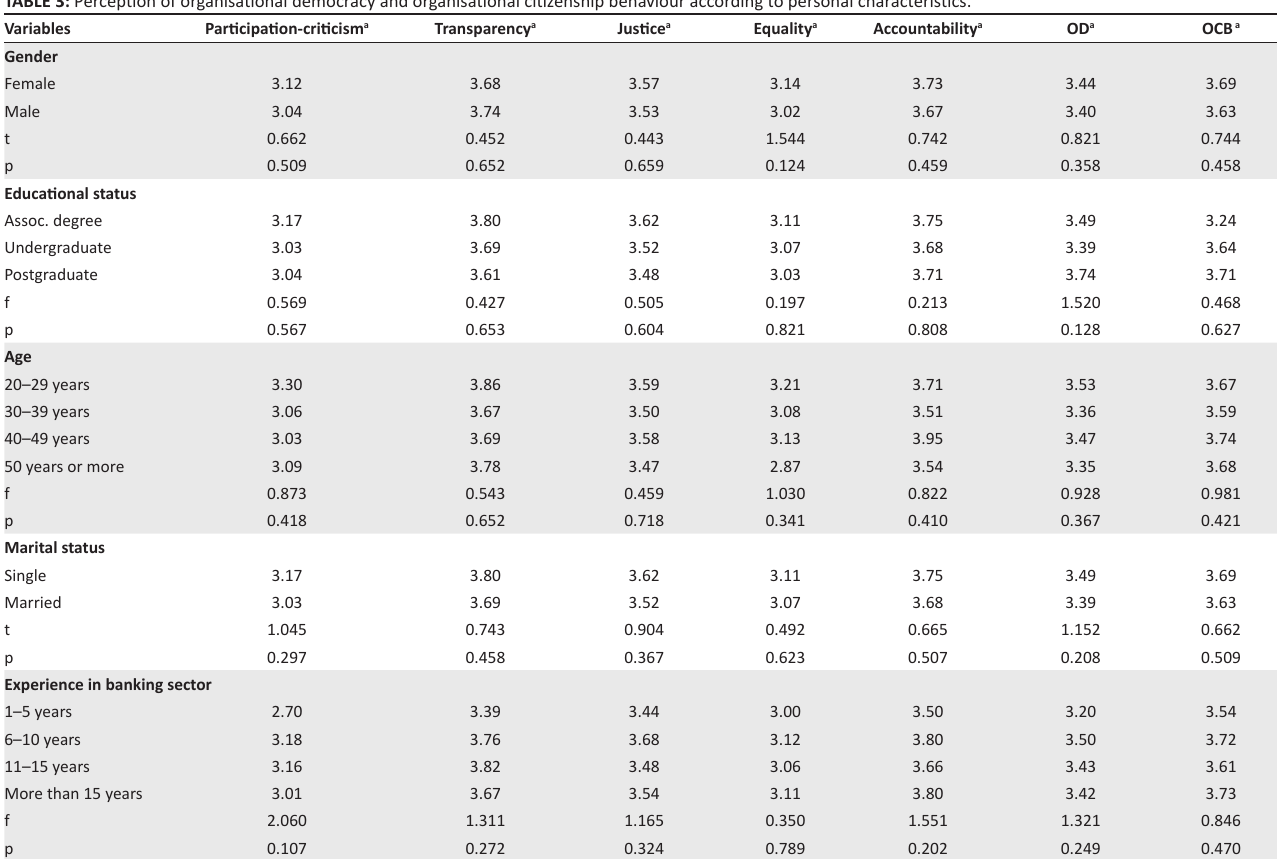
TABLE 3: Perception of organisational democracy and organisational citizenship behaviour according to personal characteristics.